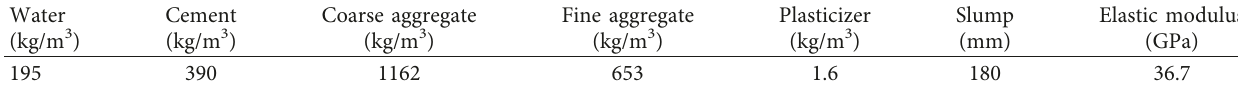
Table 1: Properties and mixture proportion of the concrete used in the present